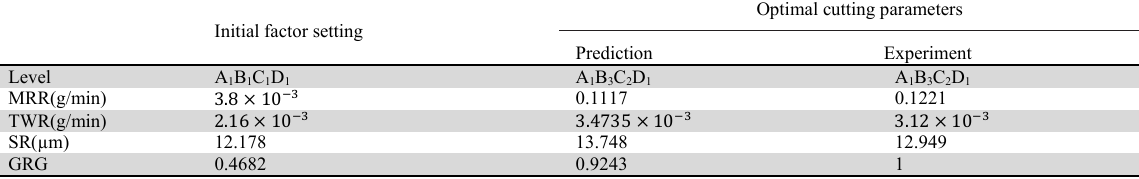
Results of the confirmatory experiment for GRA method